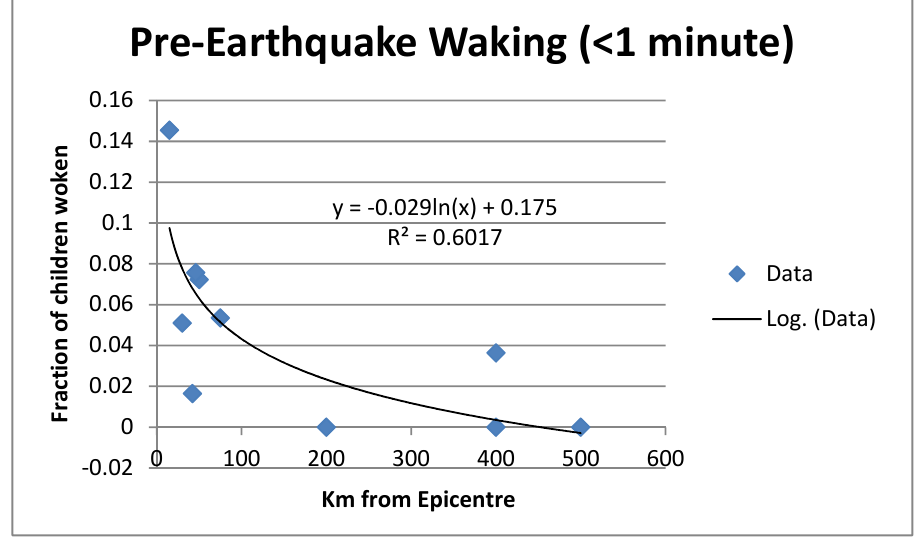
Figure 1. Log fit to data of children who woke less than a minute before the quake.